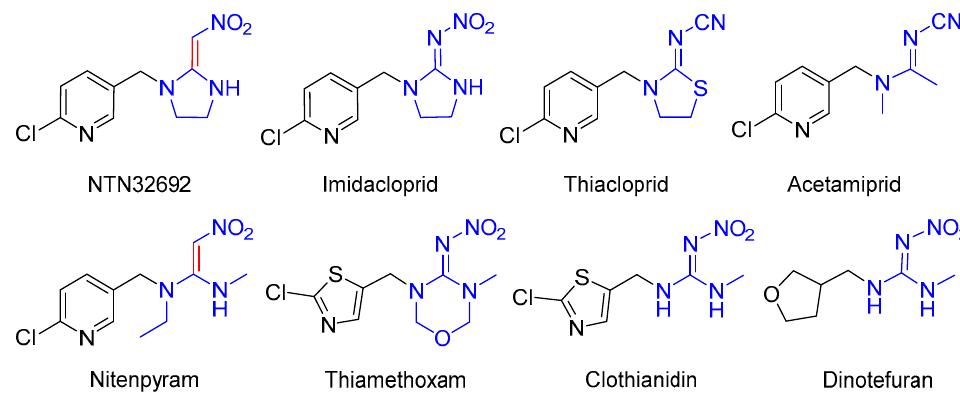
Figure 1. The lead compound NTN32692 and commercialized neonicotinoid insecticides.